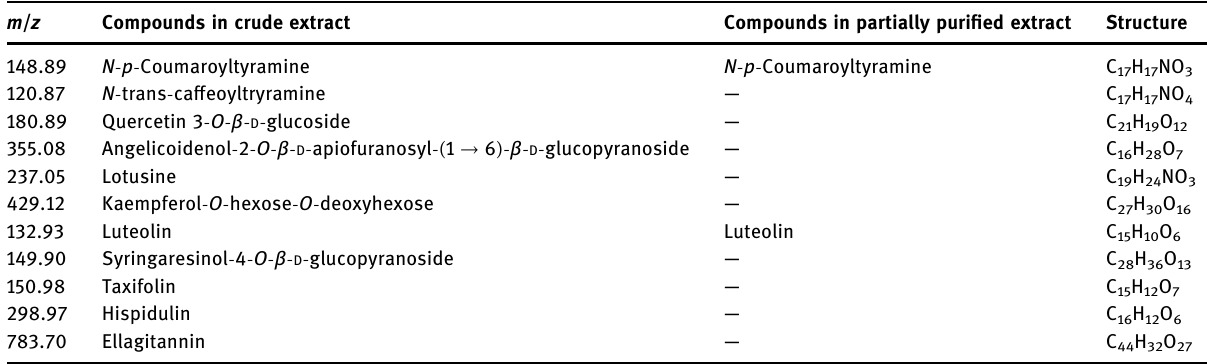
Table 5: Phytochemicals pro fi ling of crude and partially puri fi ed extracts of R. mucronata m / z